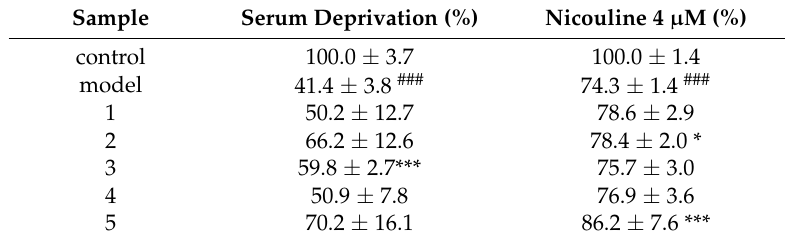
Table 3. Neuroprotective Effects of Compounds 1 – 5 at concentration of 10 − 5 M (means ± SD, n =